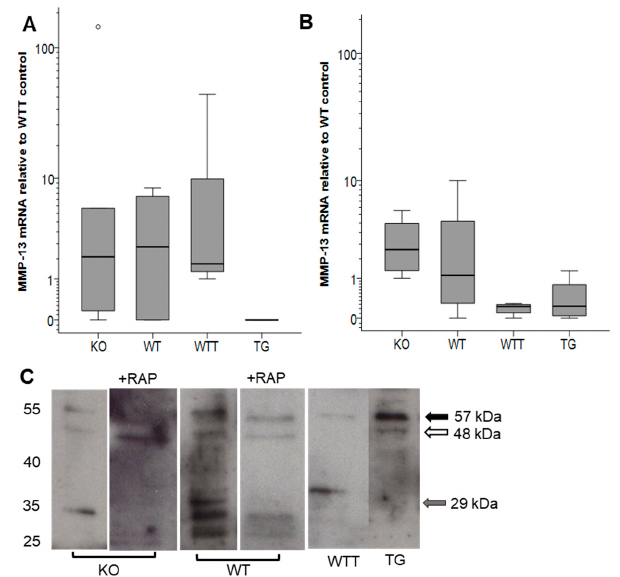
Figure 4. MMP-13 mRNA ( A , B ) and protein expression ( C ) in MMP-3 deficiency and overexpression. ( A , B ) MMP-13 mRNA expression in ( A ) native skin and ( B ) in incubated skin after eight days of culture. Boxes represent the 25 th –75 th percentile, whiskers the 5 th –95 th percentile and the horizontal lines within the boxes indicate the median values. ( C ) MMP-13 protein in conditioned media after four days of the incubation of skin explants analyzed by western blot. Molecular weights in kDa are indicated to the left. The black arrow to the right indicates the position of latent MMP-13 (57 kDa), the white arrow indicates the active MMP-13 (48 kDa) and the grey arrow to the right indicates the fragment containing the catalytic domain (29 kDa). The band below the 29 kDa band represents the C-terminal domain of MMP-13 [30]. The displayed western blot is representative of four animals in each group. The loading of samples was calculated relative to a pool of day four-conditioned media from all control samples (50 µL of each sample were mixed). The reference pool was run together with the samples on 10% SDS-PAGE gels that were stained with Coomassie blue. The density of the common band at approximately 70 kDa was used for normalization (Supplementary Figure S1). KO, MMP-3 knock-out; WT, wild-type control to KO; WTT, wild-type to transgenic mice (TG); TG, MMP-3 overexpression in the skin. +RAP, addition of receptor-associated protein (RAP).